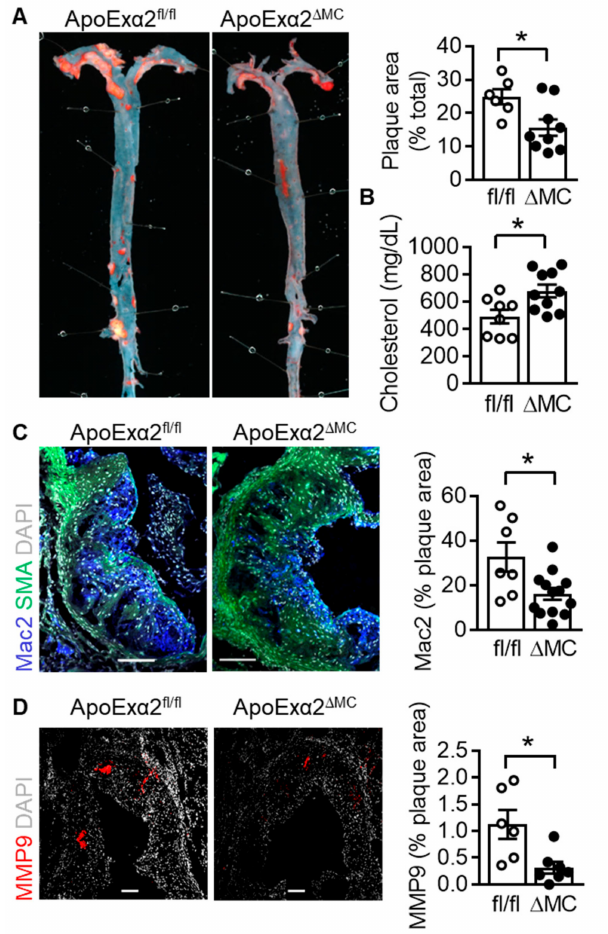
Figure 5. E ff ect of AMPK α 2 deletion in myeloid cells on atherosclerotic plaque formation. ApoEx α 2 fl / fl (fl / fl) and ApoEx α 2 ∆ MC ( ∆ MC) mice were fed a western diet for four months. ( A ) Representative pictures of oil red O stained dissected aortae and quantification of the plaque area; n = 7 to 10 animals per group (Student’s t test). ( B ) Cholesterol levels in serum from ApoEx α 2 fl / fl (fl / fl) and ApoEx α 2 ∆ MC ( ∆ MC) fed a western diet for four months; n = 8 to 10 animals per group (Student’s t -test). ( C ) Mac2 (blue) and smooth muscle actin (green) expression in aortic root plaques from ApoEx α 2 fl / fl (fl / fl) and ApoEx α 2 ∆ MC ( ∆ MC) mice, DAPI = grey; plaques from n = 7–10 mice per group. Size bar = 100 µ m (Student’s t test). ( D ) MMP9 (red) expression in aortic root plaques from ApoE - / - (fl / fl) and ApoEx α 2 ∆ MC ( ∆ MC) mice, DAPI = grey; n = 5 to 6 animals per group. Size bar = 100 µ m (Student’s t -test). * p <